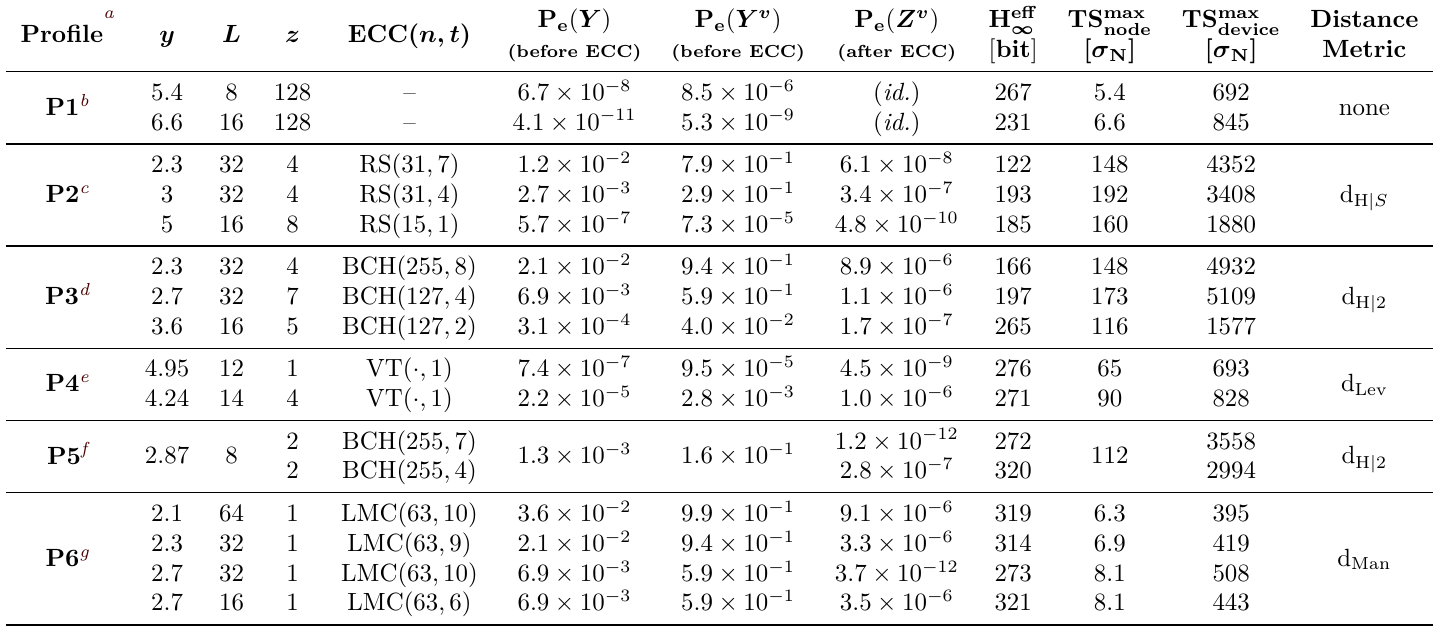
Table 1: Comparison of key derivation schemes for higher-order alphabet PUFs. Profile settings are shared among publications [IHL + , IHKS, TS] and as follows: µ X = 1 . 8 · 10 − 13 and σ X = 3 . 6 · 10 − 15 . Individual measurements of the nodes are affected by Gaussian distributed, mean-free noise with σ N = 2 · 10 − 16